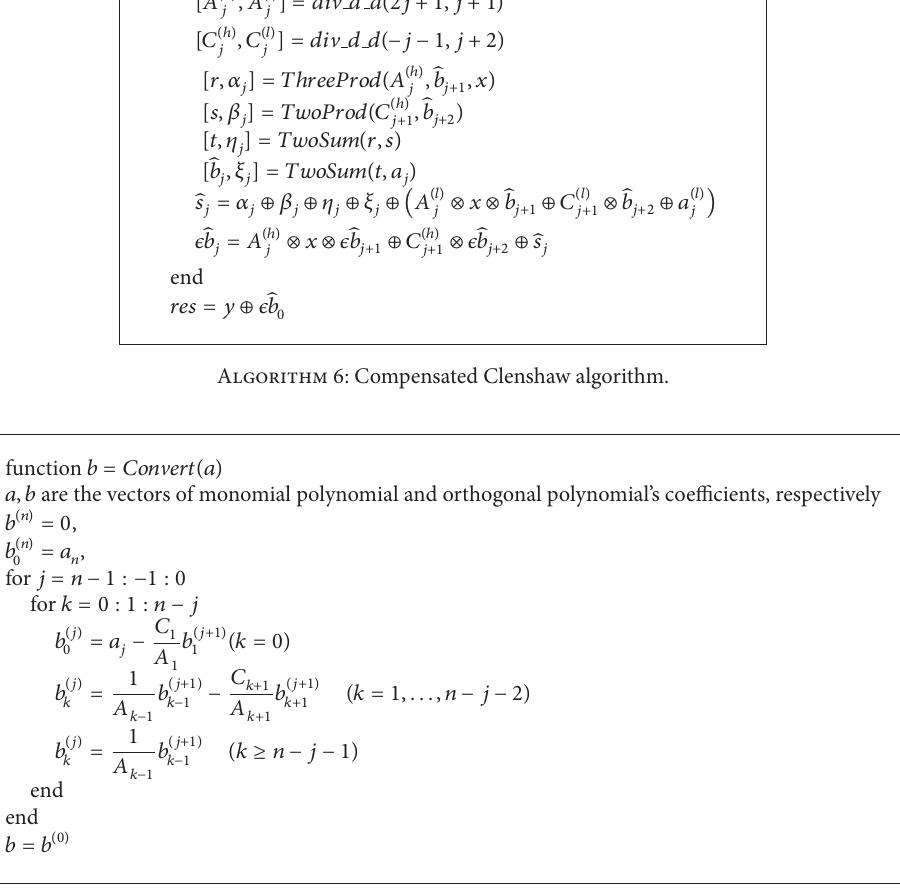
Algorithm 7: The conversion algorithm from power basis to Legendre